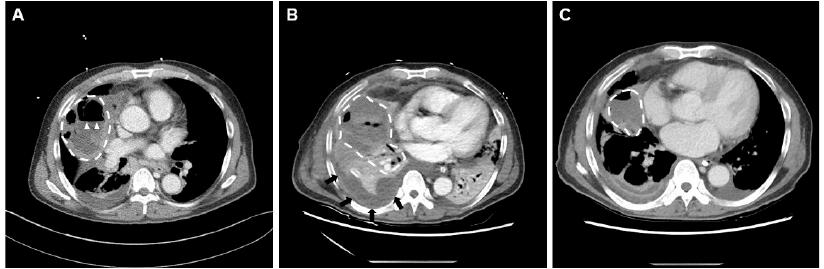
Figure 2. Chest CT findings after lung abscess development. ( A ) A CT scan taken in the emergency department revealed a lung abscess (broken lines) and an air-fluid line (arrowhead) in the right middle lobe. ( B ) A chest CT scan taken before surgery revealed abscess deterioration (broken lines), pleural effusion (black arrow), and internal necrosis. ( C ) A CT scan taken after surgery revealed improvement of the lung abscess (broken lines) and other features.